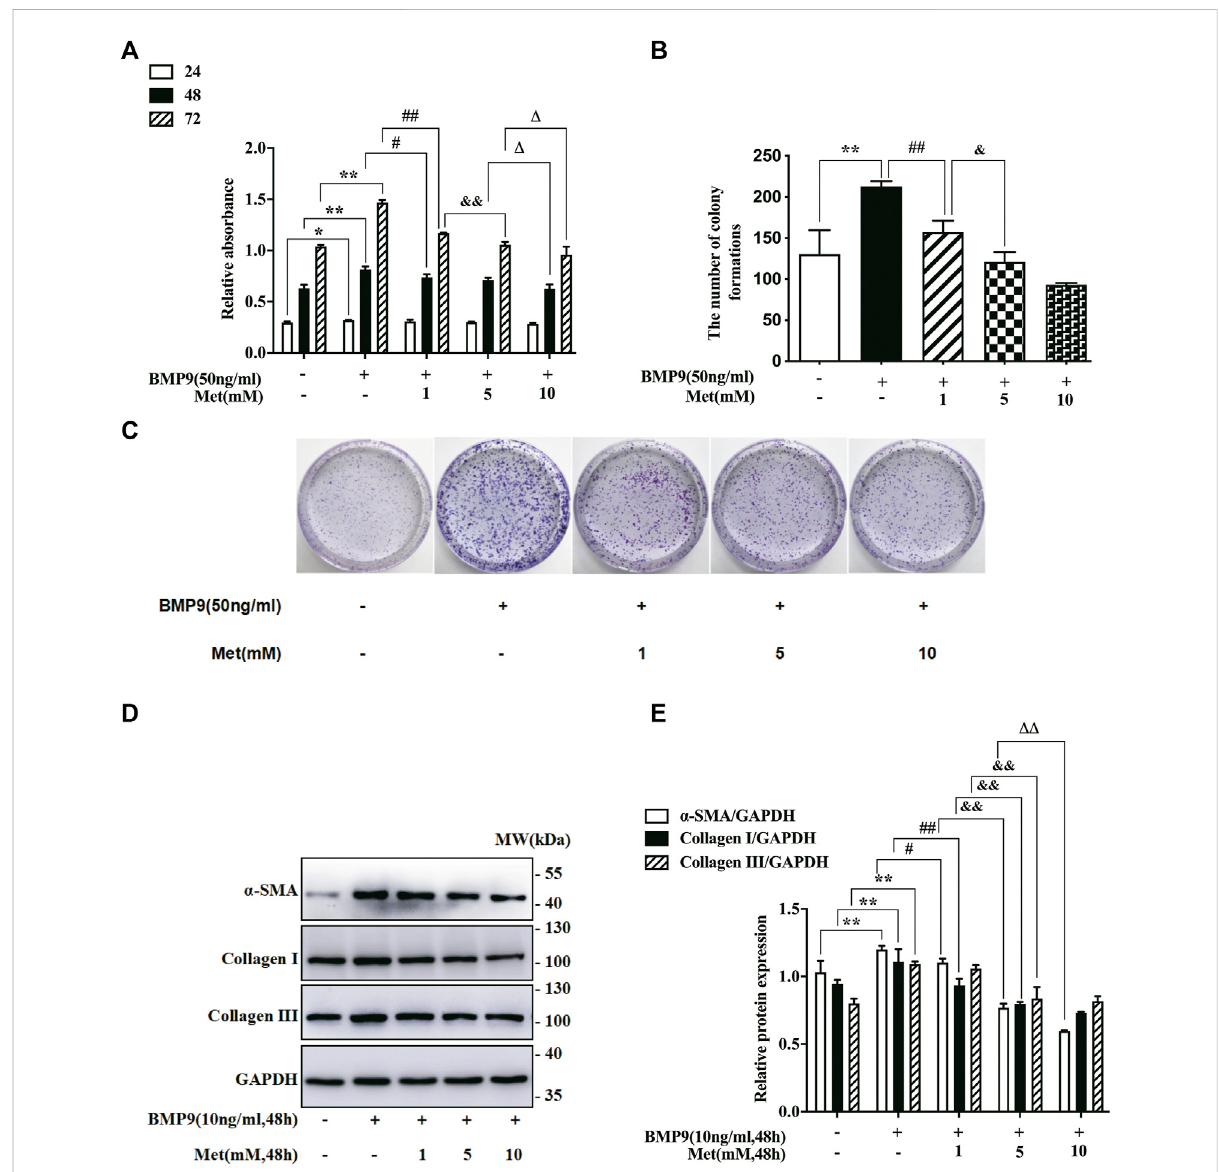
FIGURE 1 MetformininhibitedBMP9-inducedproliferationanddifferentiationofHFL-1cells. (A) :HFL-1cellsweretreatedwithdifferentconcentrationsof metformin (0, 1, 5 and 10 mM) combined with BMP9 (50 ng/ml) for 24, 48 and 72 h. The proliferative ability was detected using a CCK-8 assay and represented as the relative absorbance ( n = 3). (B,C) : HFL-1 cells were treated with different concentrations of metformin (0, 1, 5 and 10 mM) combined with BMP9 (50 ng/ml) for 10 days. The ability of colony formation was evaluated using colony formation assay ( n = 3). (D,E) : HFL-1 cells were treated with different concentrations of metformin (0, 1, 5 and 10 mM) combined with BMP9 (10 ng/ml) for 48 h. The expression levels of fi broblast differentiation marker proteins ( ɑ -SMA, Collagen I, Collagen III) were examined by western blot ( n = 3). Cells dealt with only culture medium were served as a control group. Data are presented as mean ± SD. * p < 0.05 and ** p < 0.01 versus control group; # p < 0.05 and ## p < 0.01 versus only BMP9 stimulated group; & p < 0.05 and && p < 0.01 versus the group exposed to 1 mM of metformin with BMP9; Δ P < 0.05 and ΔΔ P < 0.01 versus the group exposed to 5 mM of metformin with